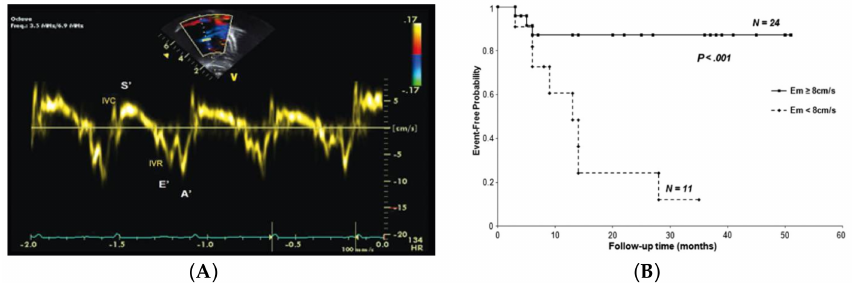
Figure 8. ( A ) A tissue Doppler spectrogram of the right ventricle at the lateral annulus of the tricuspid valve demonstrates the myocardial systolic wave (S’, reflecting the systolic longitudinal movement of the RV) and two diastolic waves (early diastolic (E’) and late diastolic (A’), which reflect the diastolic function of the ventricle); ( B ) E’ velocity less than 8 cm/s is predictive of poor outcome in pediatric IPAH